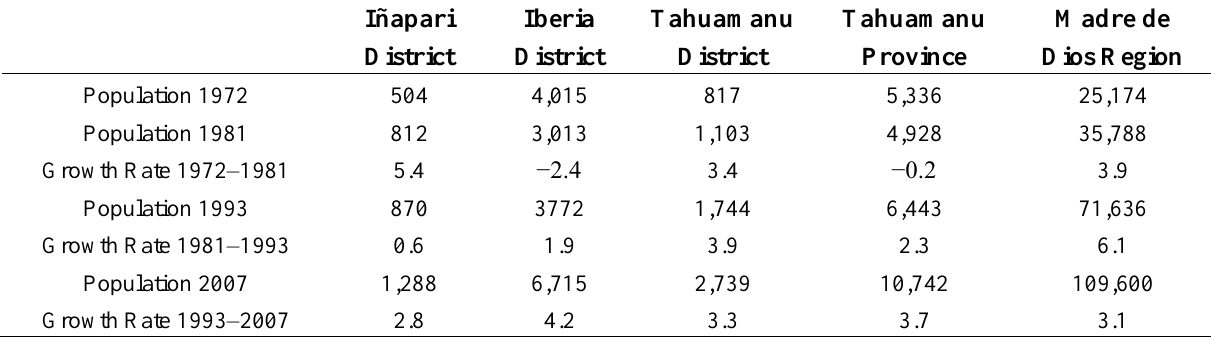
Table 3. Selected demographic data for Madre de Dios Region and Tahuamanu Province (Source: Adapted from: